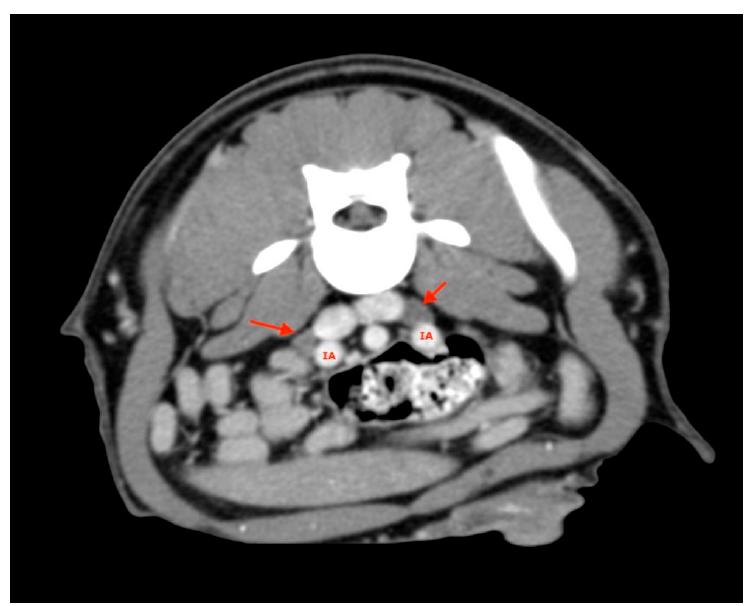
Figure 6. Medial Iliac lymph nodes (red arrows). IA, iliac artery.